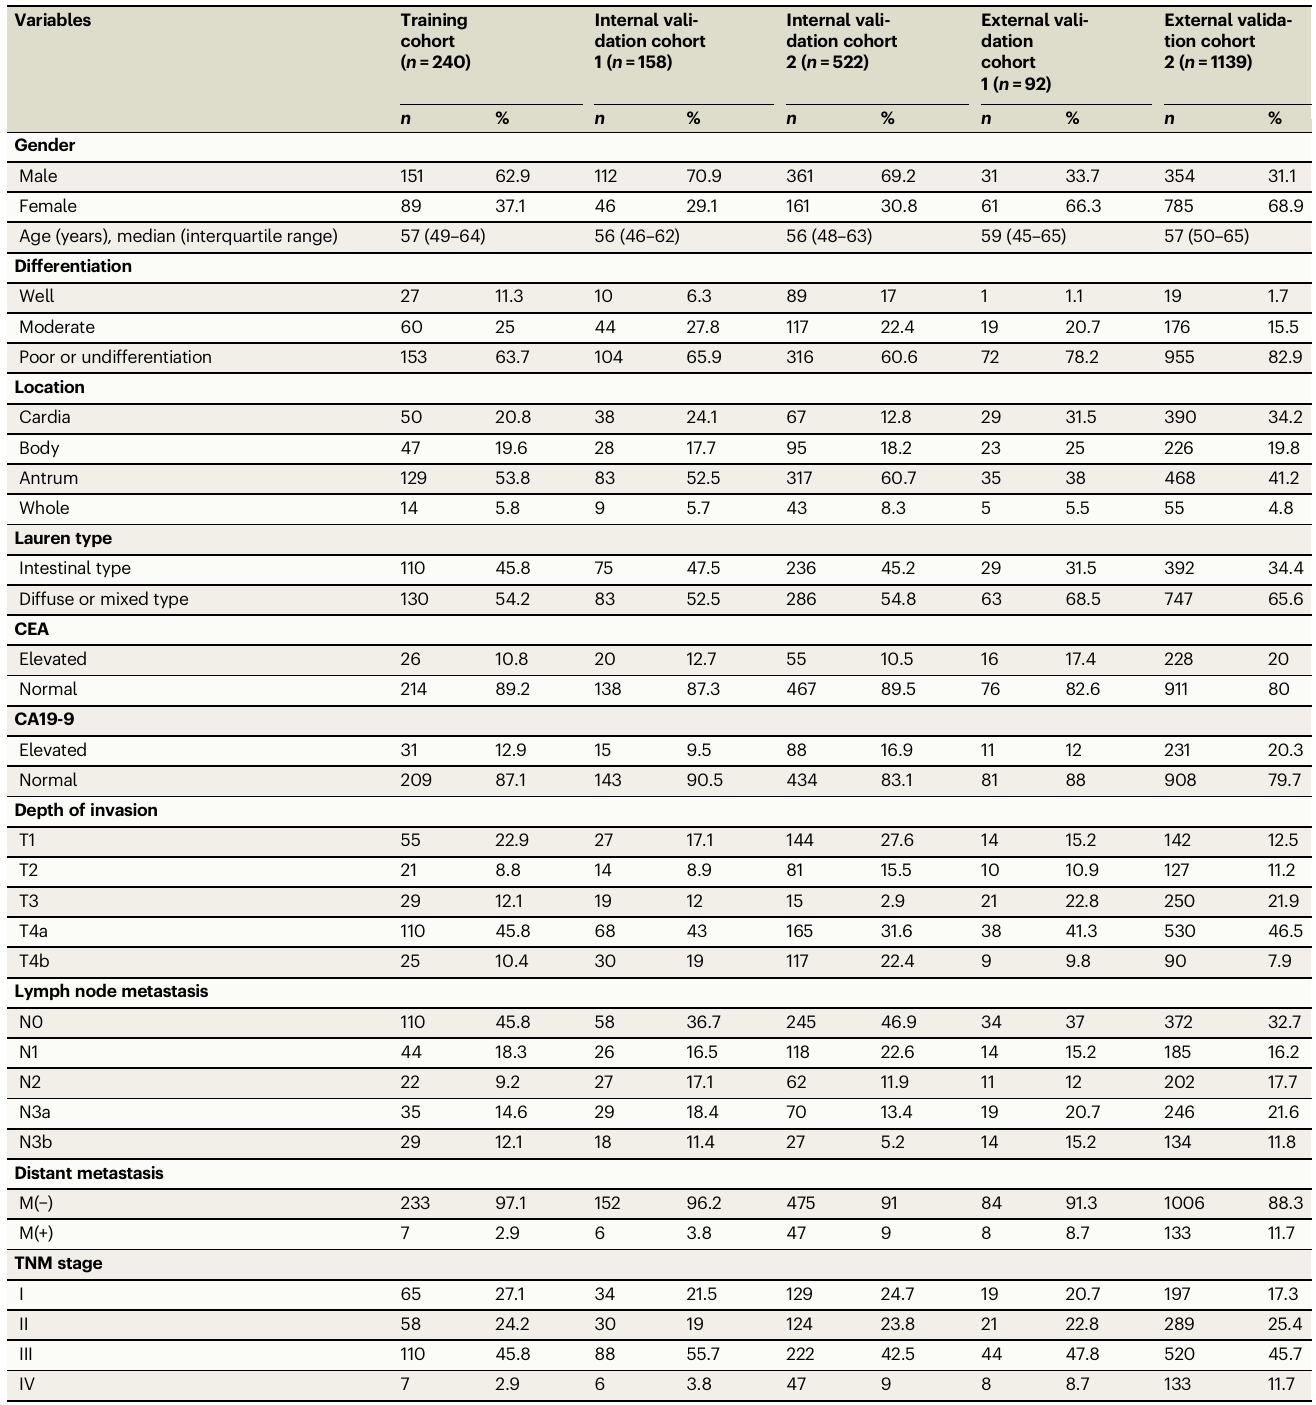
Table 1 | Characteristics of patients with GC in each cohort Variables Training